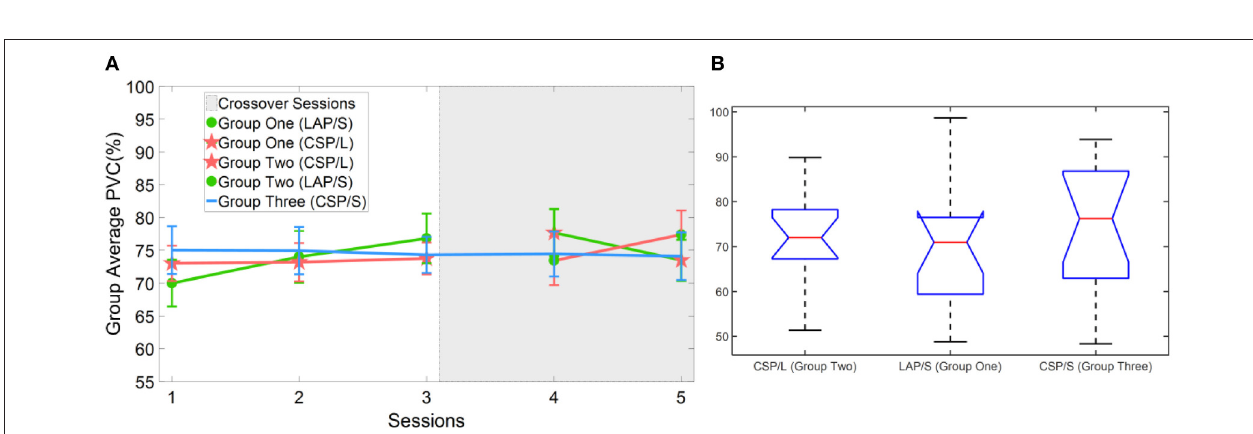
FIGURE 5 | Offline cross-validation BCI performance and statistical analysis results. (A) Offline group average BCI performance via CSP/L method and a 5 × 5 fold CV. (B) One way ANOVA test on the groups’ first session of offline BCI performance for three different groups. No significant difference was found.